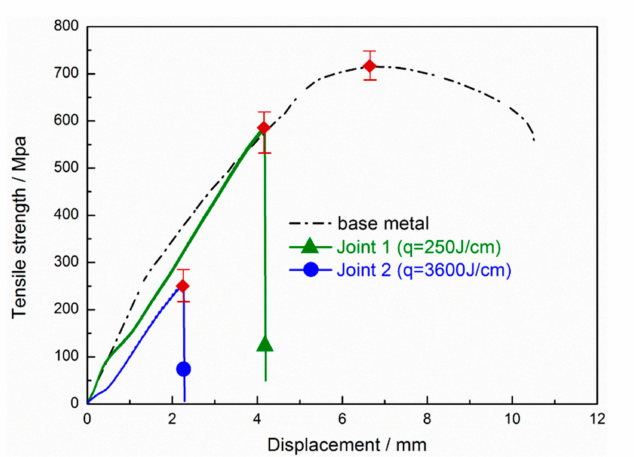
Figure 11. Tensile stress displacement curve of NS Mo base metal and its laser welding joints.